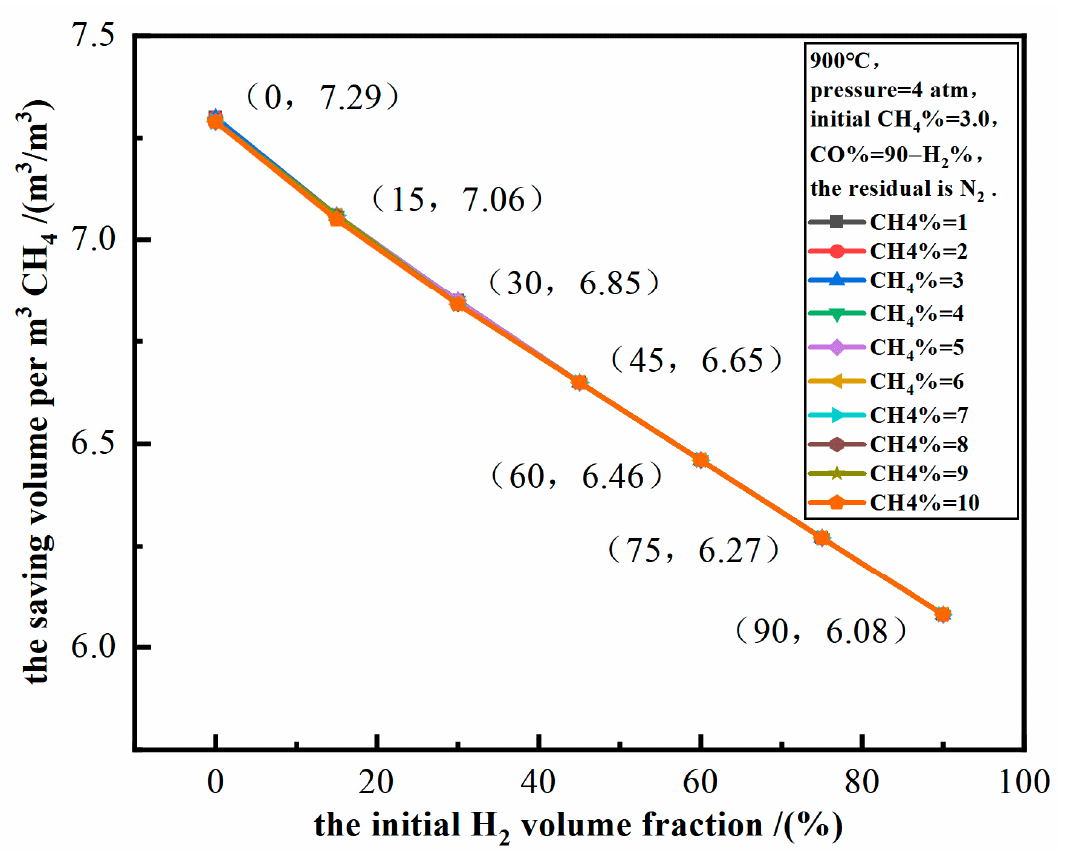
Figure 7. The relationship between the saving volume per m 3 CH 4 and initial H 2 volume fraction at 900 °C under 4 atm.